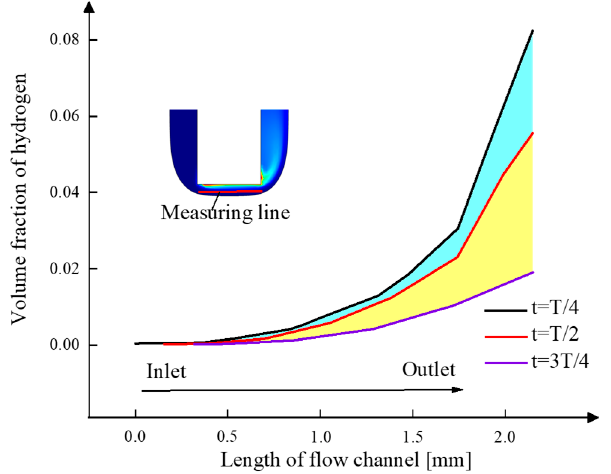
Figure 10. The volume fraction of hydrogen distribution of electrolyte.